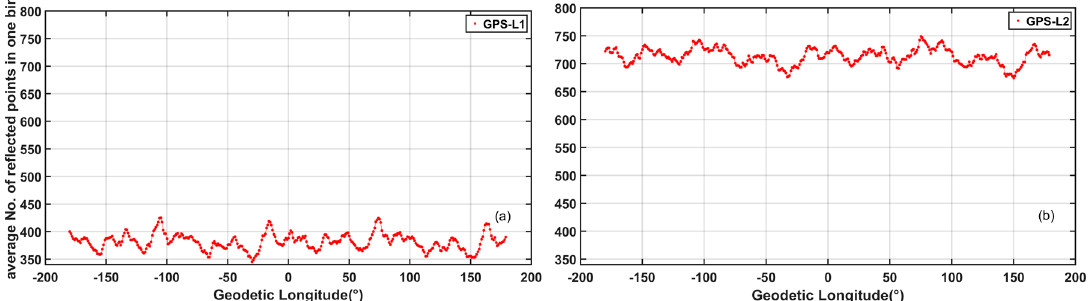
Figure 7. Average numbers of GPS-R specular reflection points in 1° × 1° grids at different longitudes during a complete 13-day cycle at the GPS L1 ( a ) and L2 ( b ) frequencies.